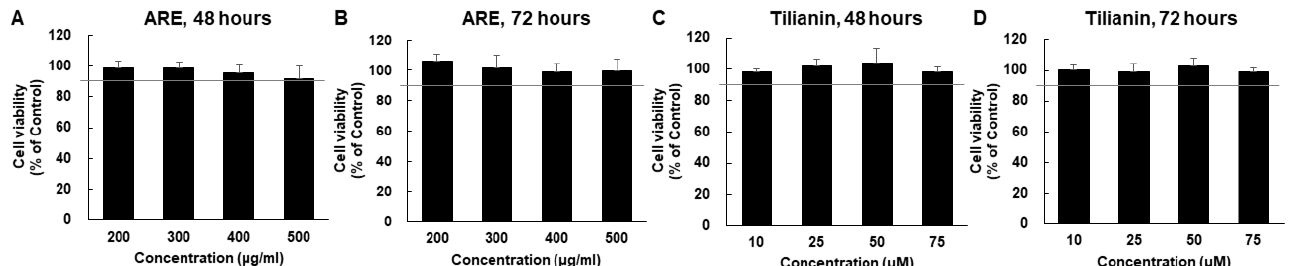
Figure 2. Cell viability (%) of 3T3-L1 cells in the presence of ARE and its bioactive compound, tilianin. 3T3-L1 cells were seeded on 96-well plate, and the cells were treated with different concentrations of ARE (200, 300, 400, 500 μ g/mL) and tilianin (Tilianin, 10, 25, 50, 75 μ M). The cytotoxicity was measured by MTT assay. ARE was treated for ( A ) 48 h and ( B ) 72 h with concentration of 200, 300, 400, 500 μ g/mL. Treated tilianin on 3T3-L1 adipocytes for ( C ) 48 h and ( D ) 72 h. The results are expressed as the mean values ± SD (n = 6). Concentration which showed higher index than 90% was selected for further experiment.